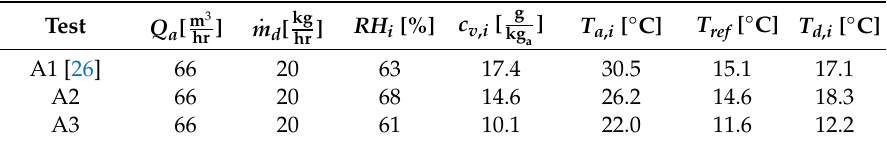
Table 2. Operating conditions for the